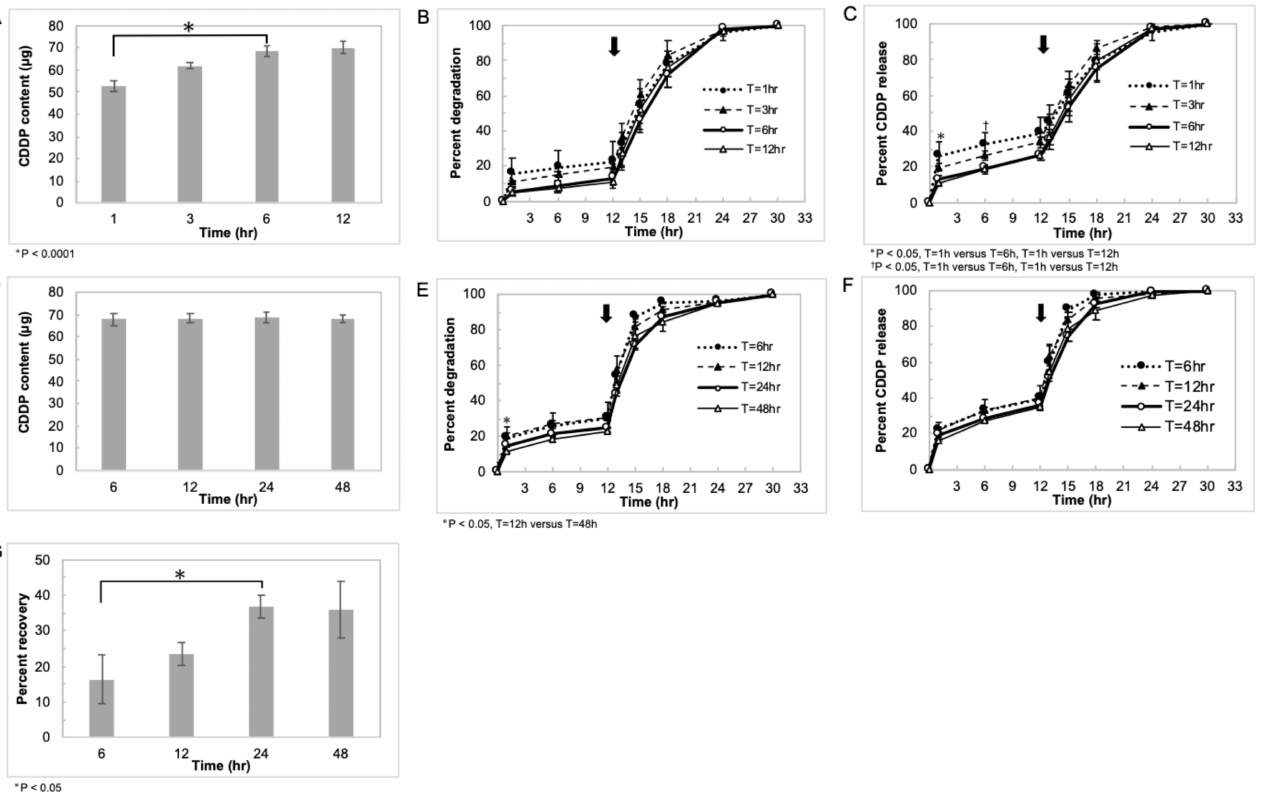
Figure 3. Characterization of CCGH prepared by varying the preparation conditions in vitro . ( A – C ) CDDP content per 1 mg CCGH ( A ), degradation profiles ( B ), and CDDP release profiles ( C ) of CCGH prepared by varying the stirring time of the gelatin aqueous solution and the CDDP aqueous solution at 40 ◦ C (1 h; dotted line, 3 h; dashed line, 6 h; thick solid line, and 12 h; thin solid line) ( n = 3). Data were represented as mean ± SD. Collagenase D was added at the time indicated by the arrow (12 h). ( D – G ) CDDP content per 1 mg CCGH ( D ), degradation profiles ( E ), CDDP release profiles ( F ), and recovery rate ( G ) of CCGH prepared by varying the standing time of the stirred solution at 4 ◦ C (6 h; dotted line, 12 h; dashed line, 24 h; thick solid line, and 48 h; thin solid line). ( n = 3). Data were represented as mean ± SD. Collagenase D was added at the time indicated by the arrow (12